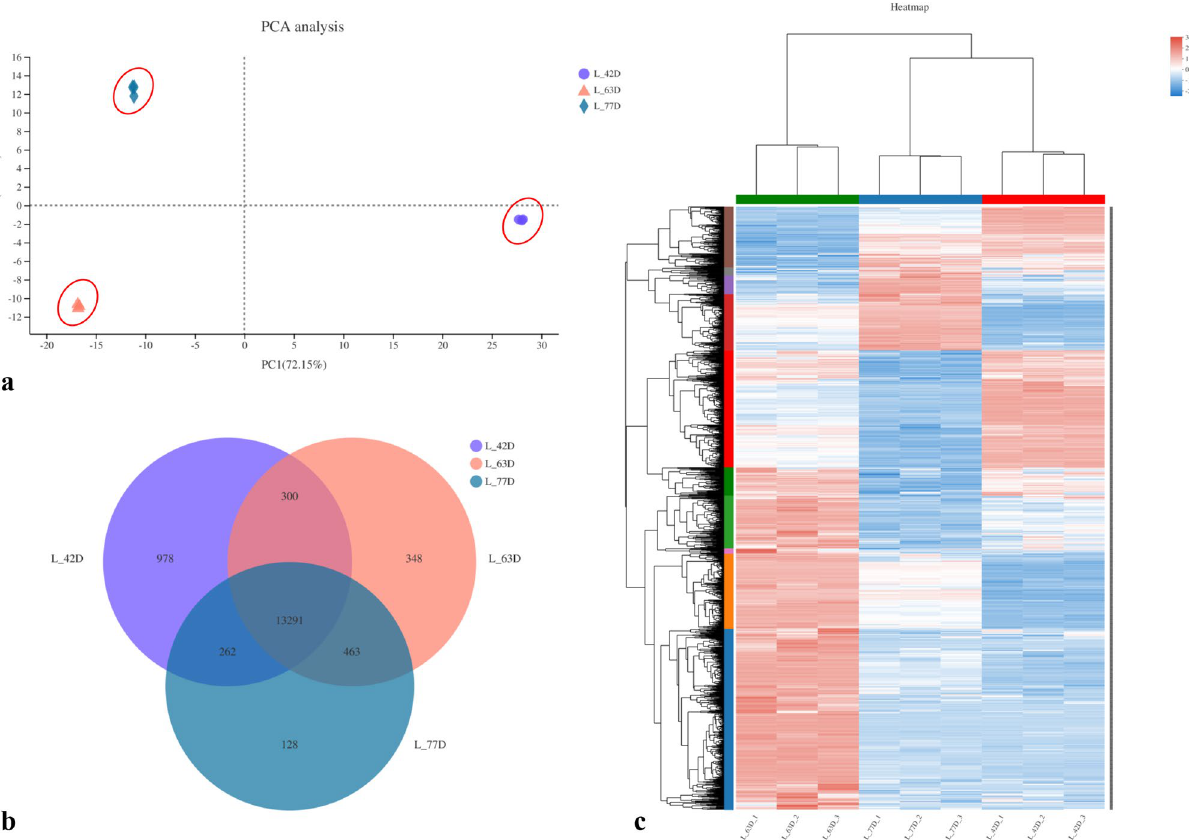
Figure 4. PCA diagram, Venn diagram ( b ) and heat map of the correlation ( c ) of DEGs among 3 stages of “Luntaibaixing”